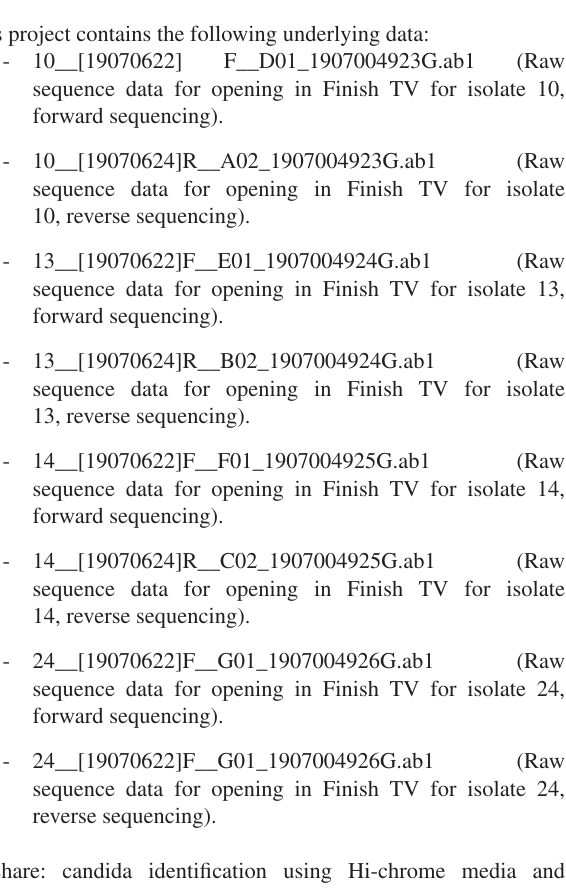
Figshare: sequence data for ERG11 gene. https://doi.org/10.6084/ m9.figshare.12600128.v1 31